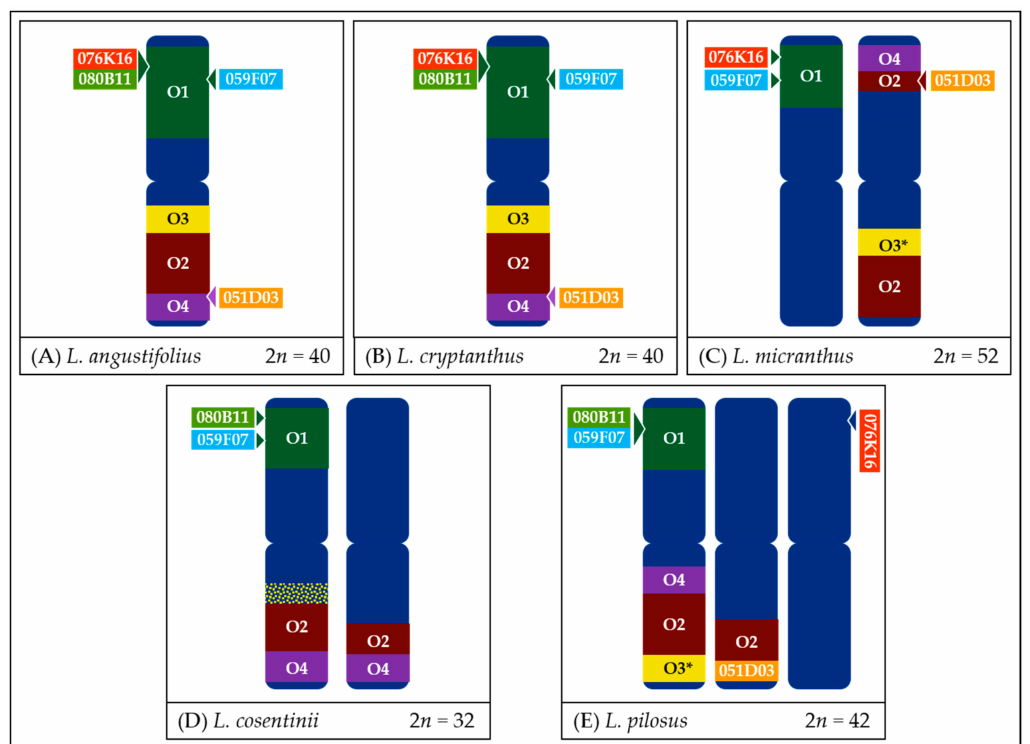
Figure 8. Schematic representation of probe mapping pattern, showing observed positions of particular oligonucleotide-based or BAC-based probes in L. angustifolius ( A ), L. cryptanthus ( B ), L. micranthus ( C ), L. cosentinii ( D ), and L. pilosus ( E ) chromosomes. In the case of probe O3 in L. micranthus and L. pilosus , beside two major loci, minor signals were also noticed. In L. cosentinii , the O3 probe hybridized to multiple loci. Chromosome schemes and probes length are not drawn to